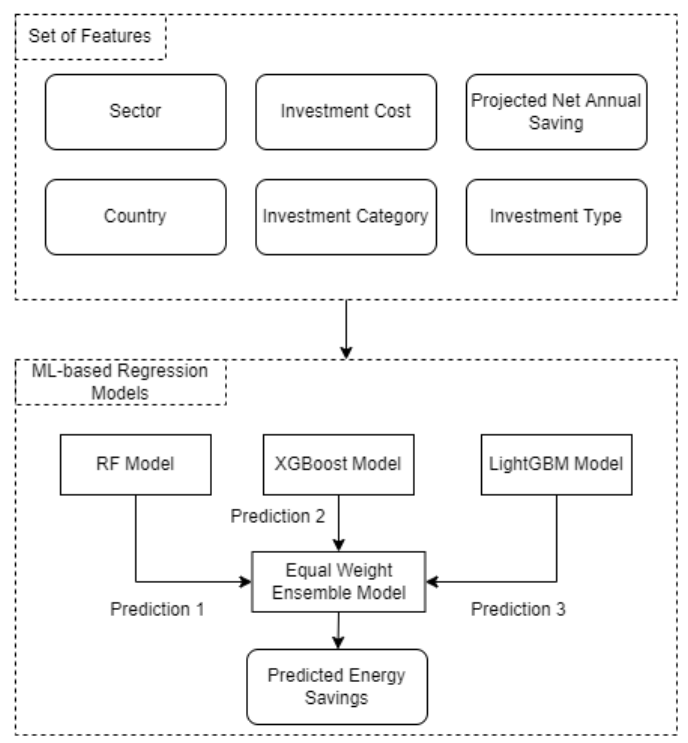
Figure 4. Structure of the experimental